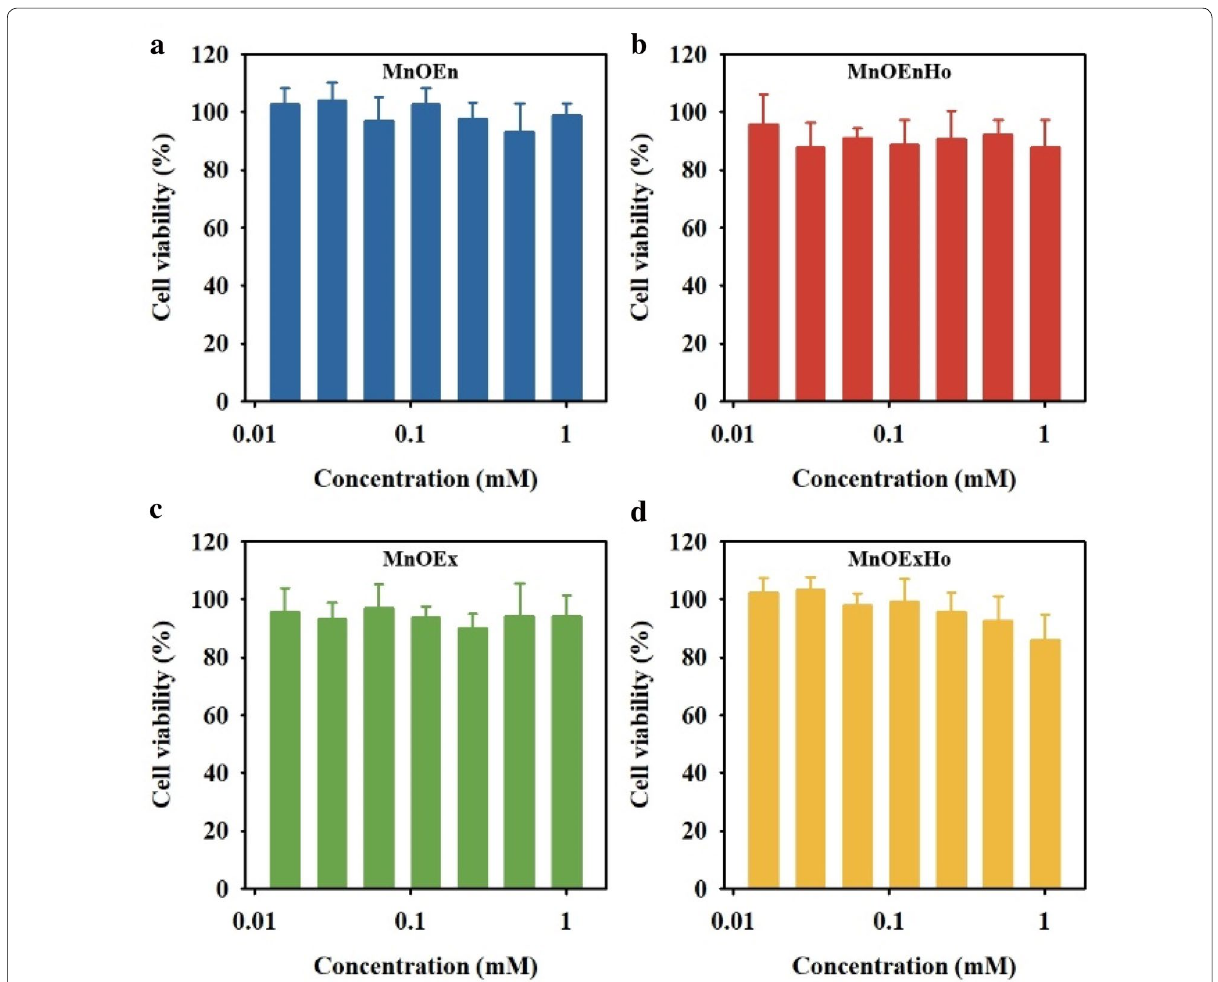
Fig. 6 Cell viability of SNU‑484 cells incubated with a MnOEn (blue), b MnOEnHo (red), c MnOEx (green) and d MnOExHo (yellow) at various concentrations for 24 h at 37